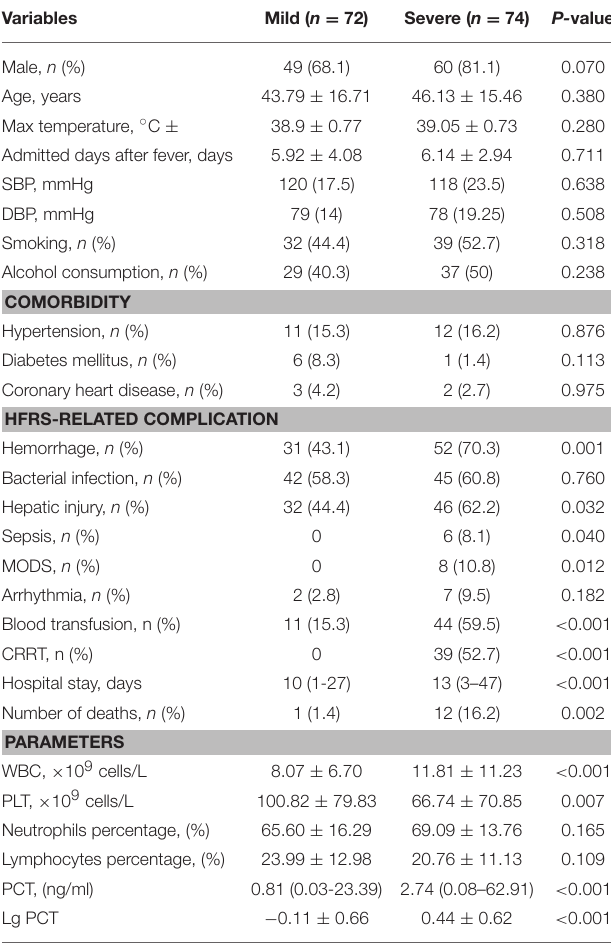
TABLE 1 | Demographics and clinical and laboratory data at admission in the patients with HFRS of different clinical types.